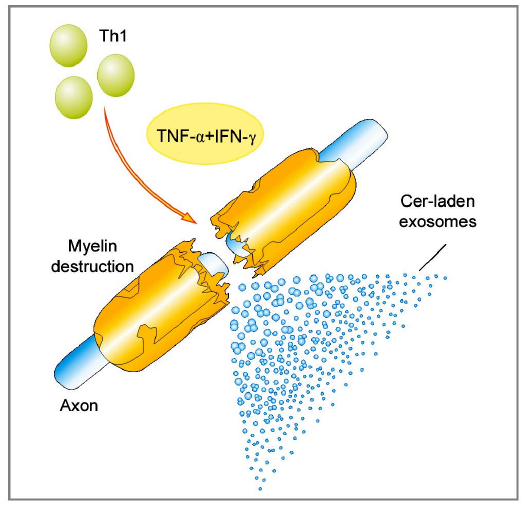
Figure 3. Cer-laden exosomes drive acute inflammatory demyelination in MS. Abbreviations: Cer— ceramide, IFN- γ —interferon γ , MS—multiple sclerosis, Th—T helper, TNF- α —tumor necrosis factor α . Adapted from [36].